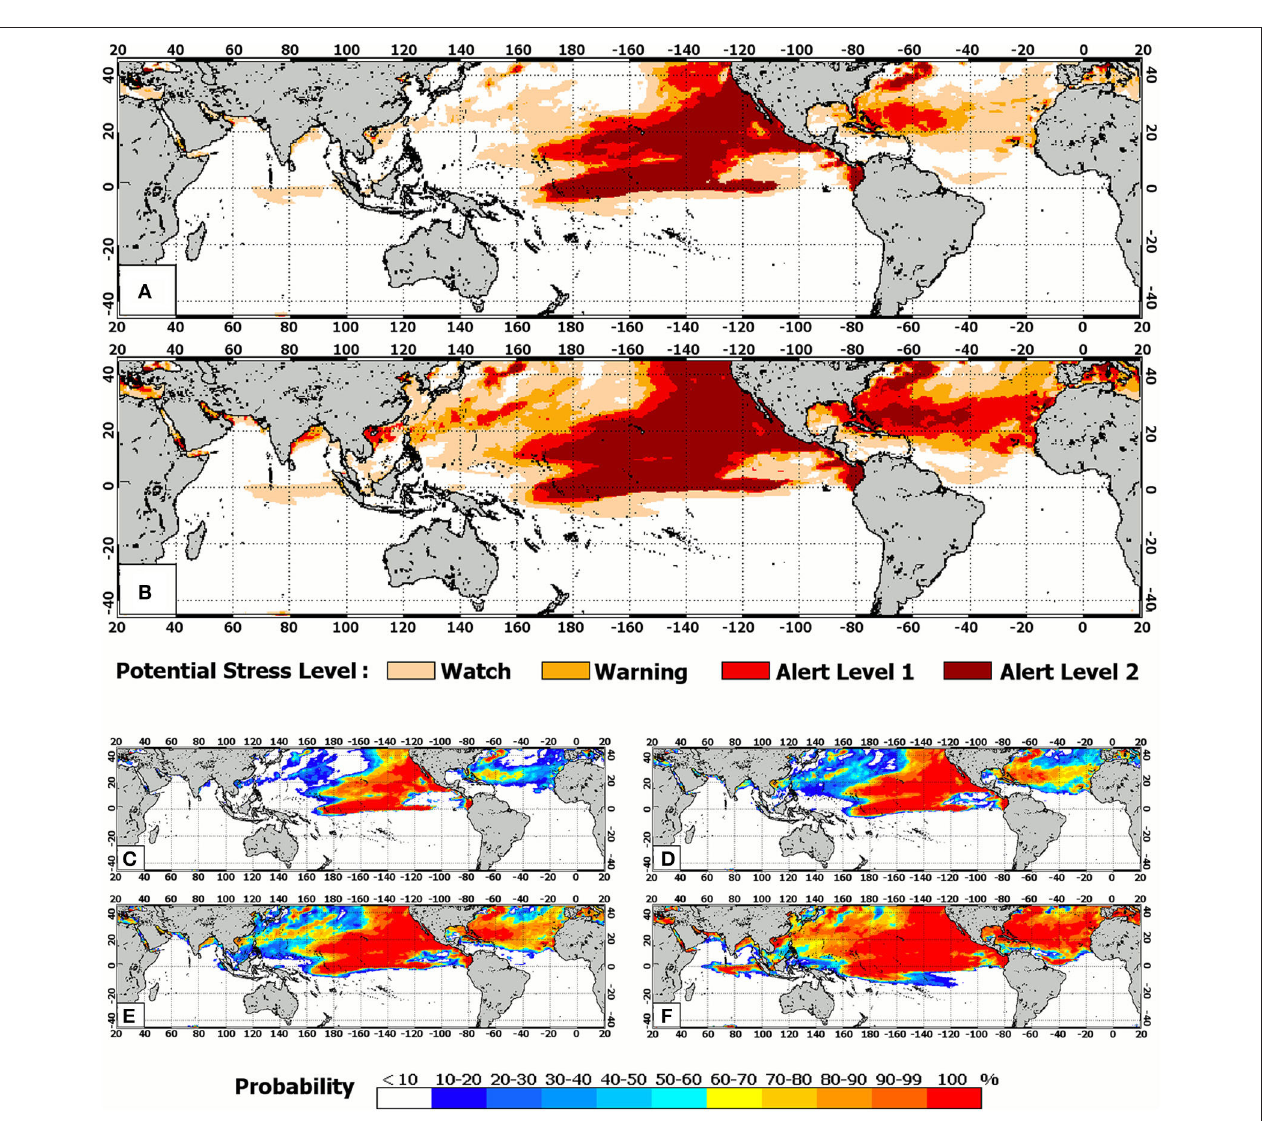
FIGURE 2 | CRW’s probabilistic 4-Month Coral Bleaching Outlook Version 3 issued on July 7, 2015 for July–October 2015: stress levels with (A) 90% and (B) 60% probabilities; probabilities for (C) Alert Level 2, (D) Alert Level 1 and higher, (E) Warning and higher, and (F) Watch and higher. Note that the Outlook was derived for each grid cell in the maps regardless of the existence of shallow-water coral reefs at that specified grid